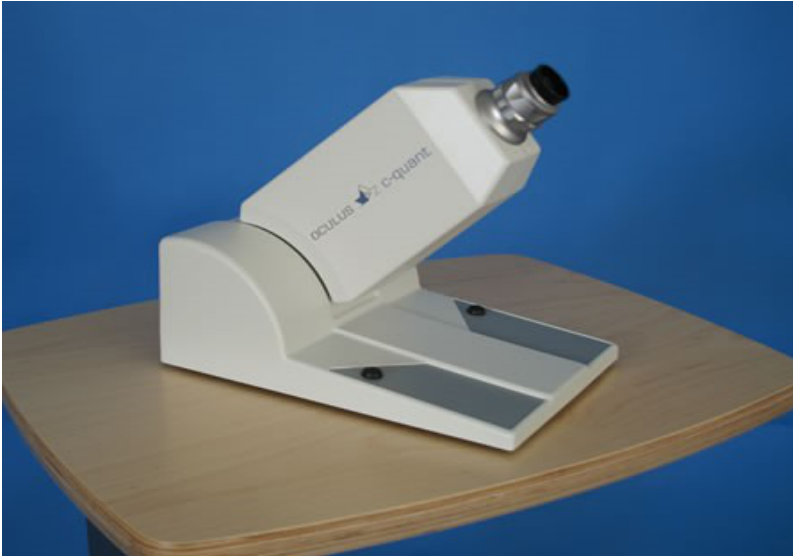
Figure 1. C-Quant equipment. Left and right black buttons located on the silver area at the base were used to the 2-Alternated Forced Choice left–right judgment.